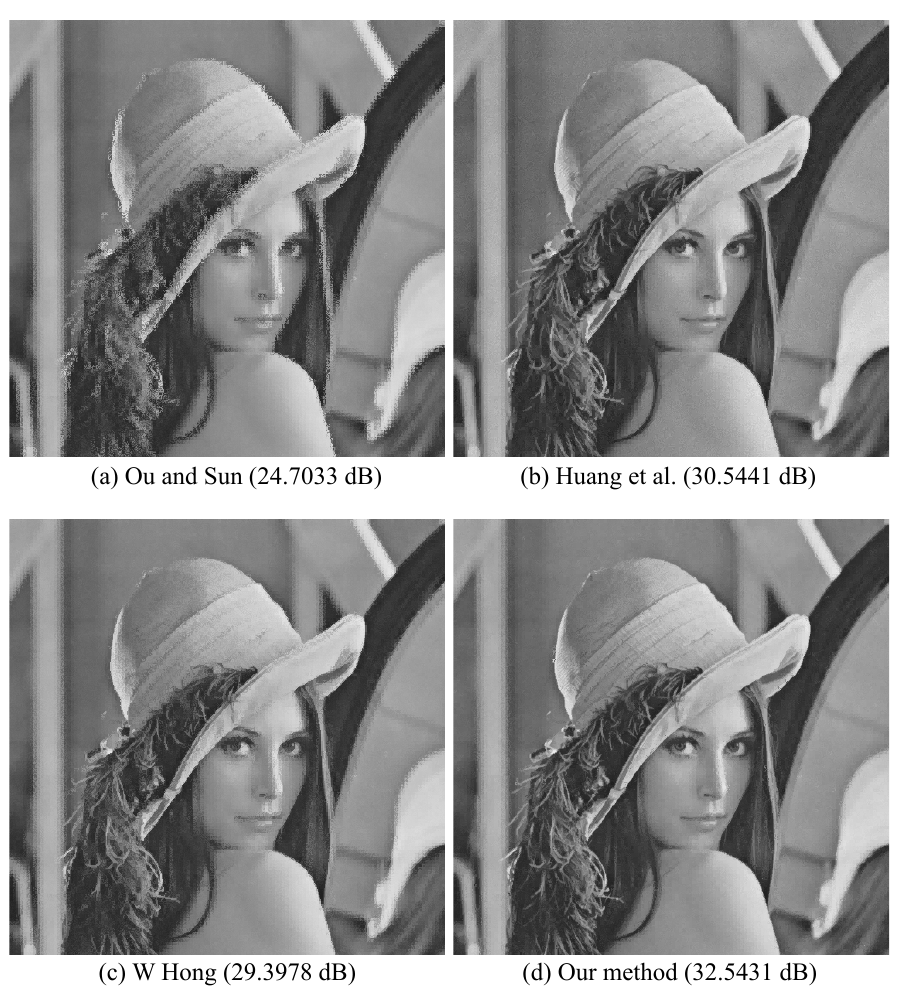
Figure 6. Visual comparison after embedding the same 280,000 bits into the Lena image by using four different methods such as ( a ) Ou and Sun [19], ( b ) Huang et al. [20], ( c ) W. Hong [21], and our proposed